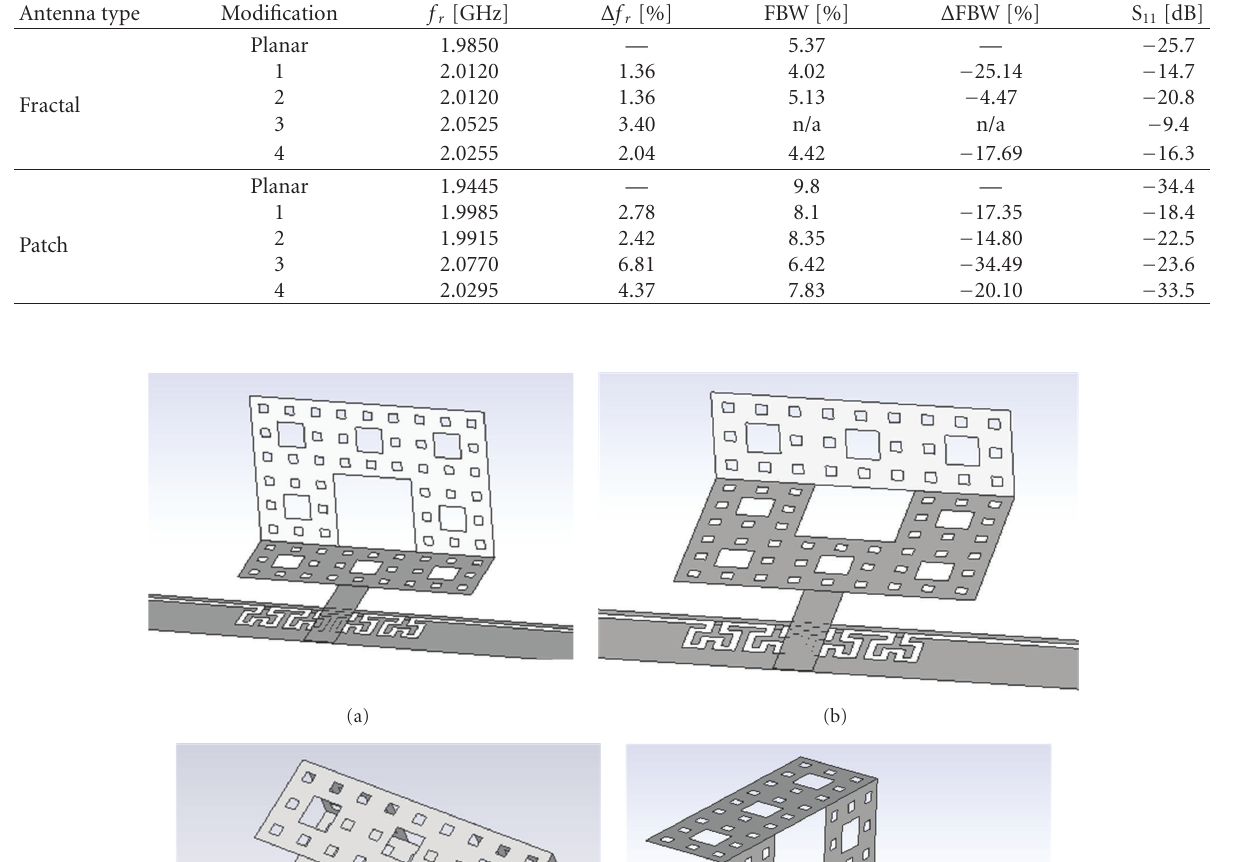
Table 1: Detailed comparison between performances of the proposed fractal and the conventional patch antenna, for both the planar and the folded cases.